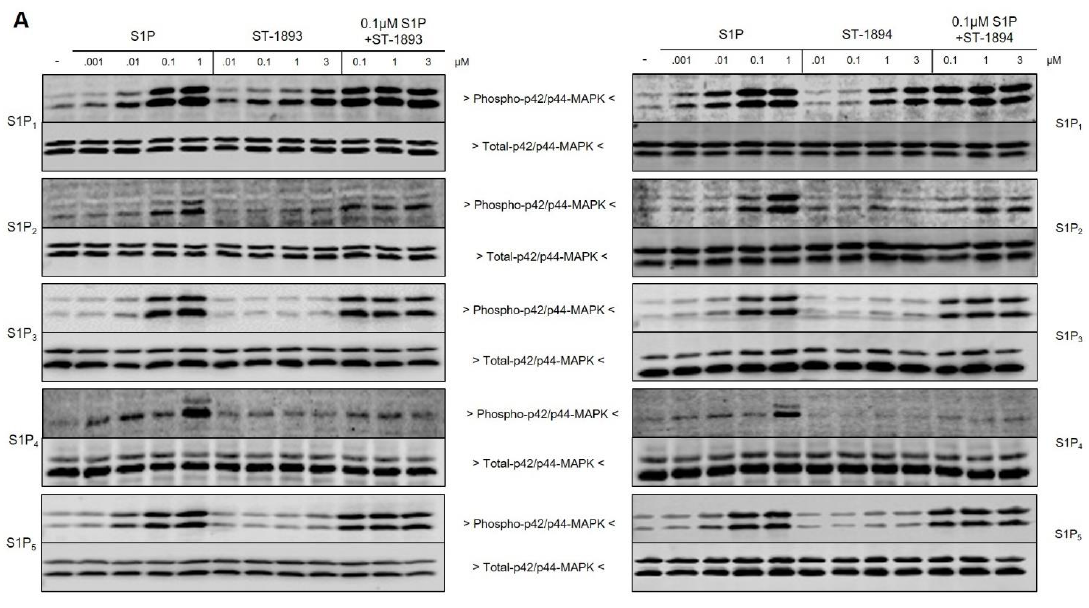
Figure 2. Characterization of ST-1893 and ST-1894 for agonistic and antagonistic activity on each sphingosine 1-phosphate receptor (S1PR) subtype. Starved confluent Chinese hamster ovary (CHO)- K1 cells, which stably overexpress S1P 1 , S1P 2 , S1P 3 , S1P 4 , or S1P 5 receptors, were treated for 10 min with increasing concentrations of S1P, ST-1893 ( left panels ), and ST-1894 ( right panels ) (all in µ M), or with 100 nM S1P in the presence of increasing concentrations of ST-1893 or ST-1894. Protein extracts were prepared, separated by SDS-PAGE, transferred to nitrocellulose, and subjected to Western blot analysis as described in Section 4. Membranes were incubated with phospho- and total p42/p44- mitogen-activated protein kinase (MAPK). Blots in ( A ) show one representative out of three independent experiments. The graph in ( B ) shows the quantification of p42/p44-MAPK activation in CHO-S1P 1 cells and depicts the means of three independent experiments. We further studied whether ST-1893 and ST-1894 could act as antagonists. For this, cells were stimulated with a fixed concentration of S1P in the presence of increasing concentrations of either ST- 1893 or ST-1894. However, no reduction of S1P-stimulated p42/p44-MAPK activation was detected, excluding a direct antagonistic effect of ST-1893 and ST-1894 (Figure 2A). Furthermore, ST-1893- and ST-1894-stimulated p42/p44-MAPK activation was completely abolished by pretreatment with the competitive S1P 1 antagonist NIBR-0213 (Figure 3A) [16] and by pertussis toxin (Figure 3B), thus confirming the reported signaling of S1P 1 and the involvement of G i/o .